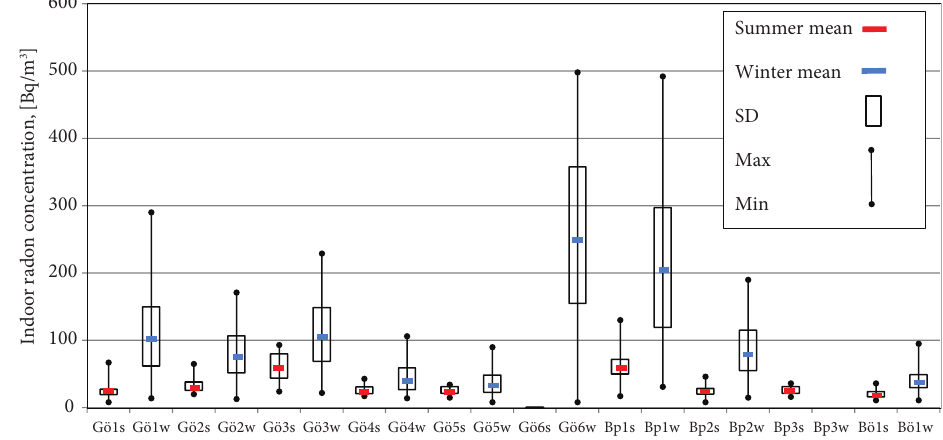
Figure 2. Indoor radon concentration for 2015 summer and 2016 winter at the different family